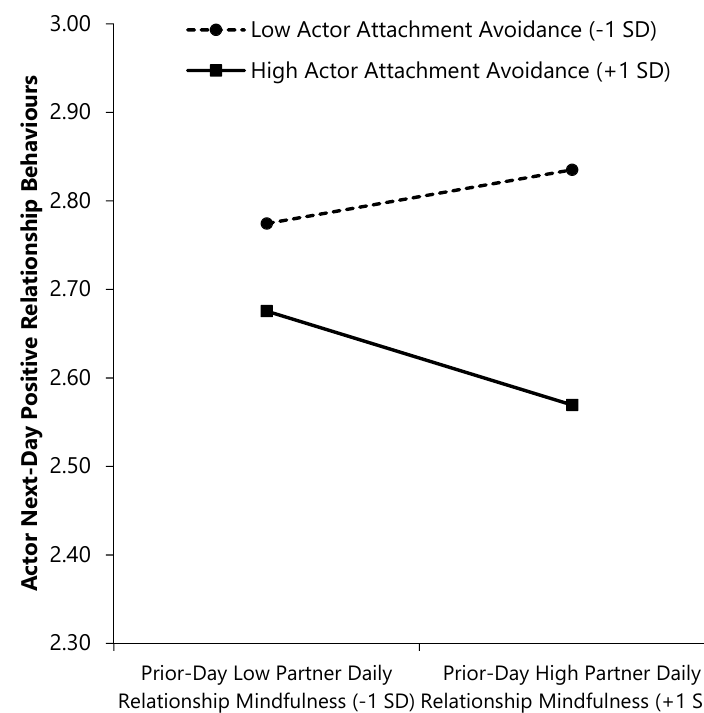
Figure 5. Interactions of attachment avoidance and prior-day relationship mindfulness with next-day positive relationship behaviours. Higher scores on continuous variables represent greater standing on the variable (e.g., higher daily RM).